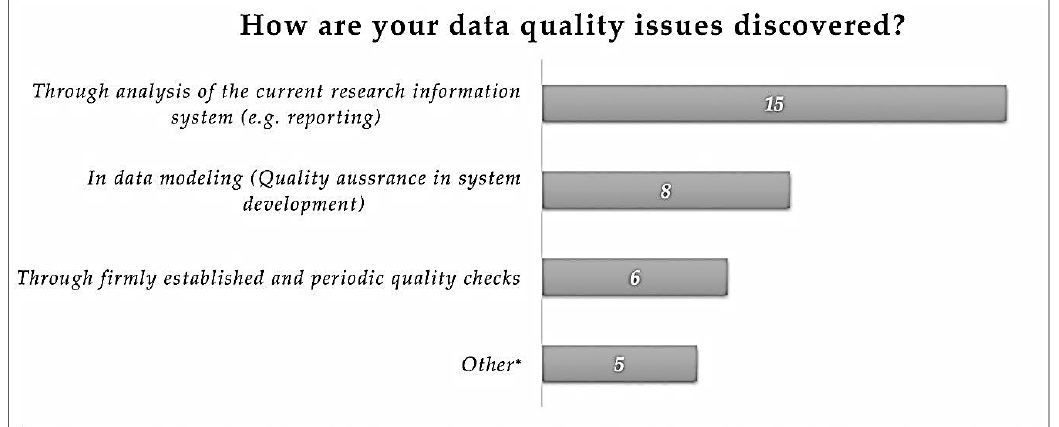
Figure 4. Discovery of data quality issues in CRIS ( N = 17 ).